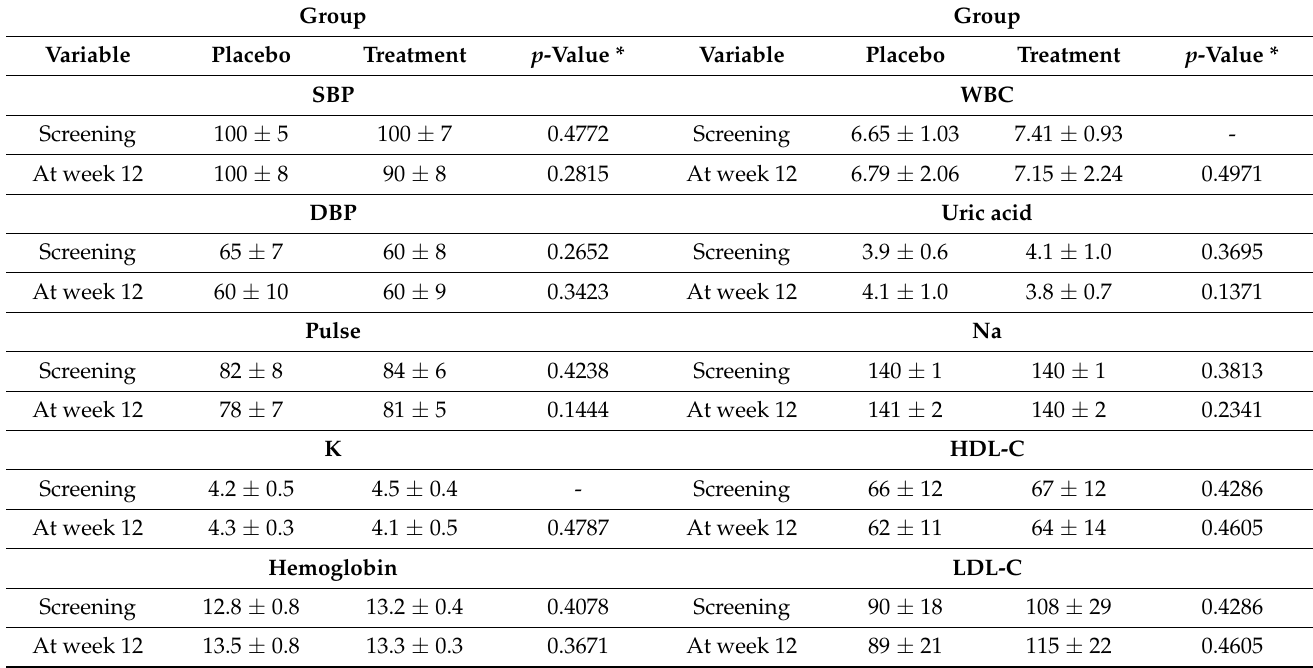
Table 5. Safety Comparison by Placebo and Treatment group at each assessment